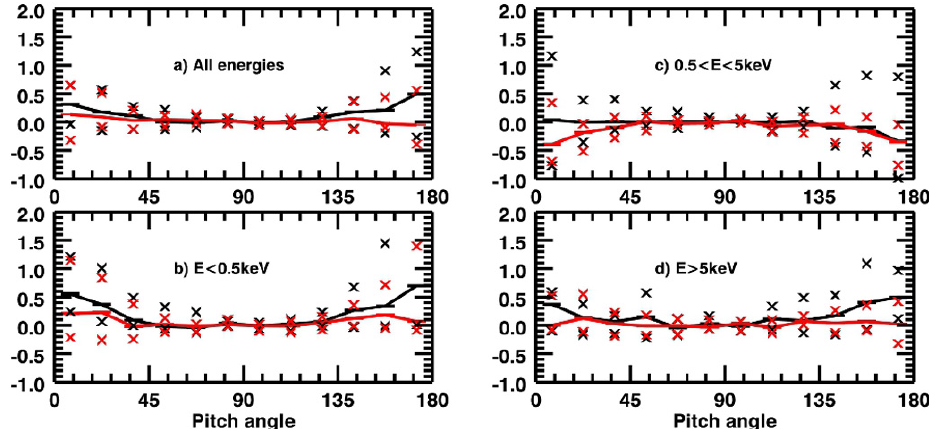
Fig. 4. Median difference between the normalized median inflow electron flux and the median outflow electron flux . All time intervals from all ion diffusion region encounters are included. Black line: Cluster spacecraft 1, red line: Cluster spacecraft 4. Crosses: first and third quartile of the distributions. (a) All energies, (b) electron energies 70eV–500eV, (c) electron energies 500eV–5keV, (d) electron energies